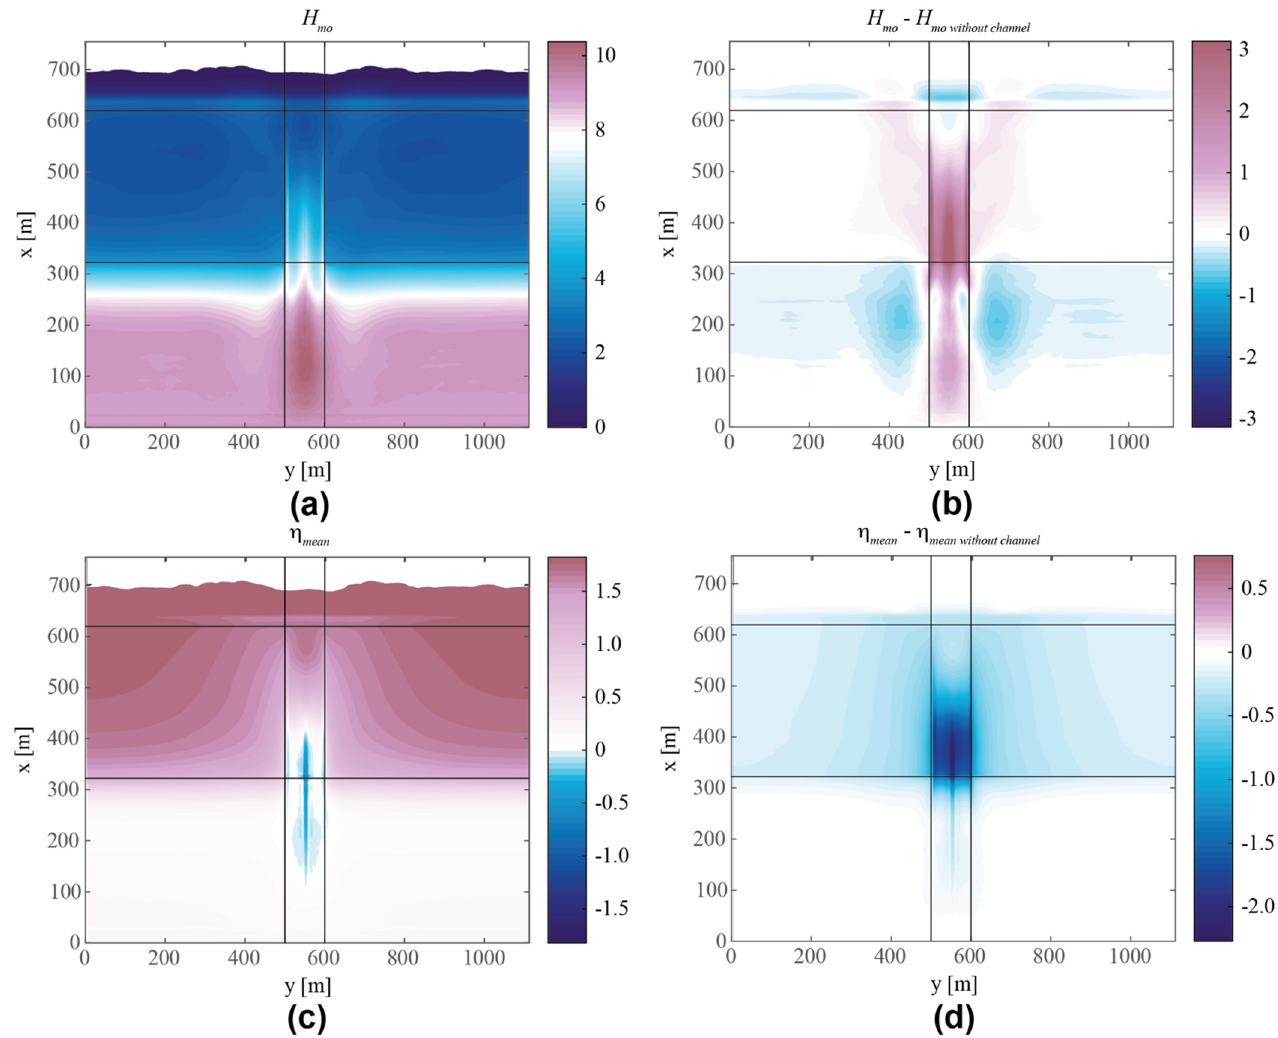
Figure 3. Map views of wave height and setup across the reef for large ( Ho = 7 m) and long-period ( T p = 15 s) offshore waves. ( a ) Mean wave height, H m0 . ( b ) Mean wave height, H m0 , relative to the reference run with the same forcing but without a channel. ( c ) Mean setup, η mean . ( d ) η mean , relative to the reference run with the same forcing but without a channel. The red zones indicate higher values in the case with a channel as compared to the reference case without a channel, and the blue zones indicate smaller values in the case with a channel. In these plots, offshore is on the bottom at x = 0, the reef crest at x = 320 m, and the still-water shoreline at x = 620 m; the channel extends from y = 500–600 m.